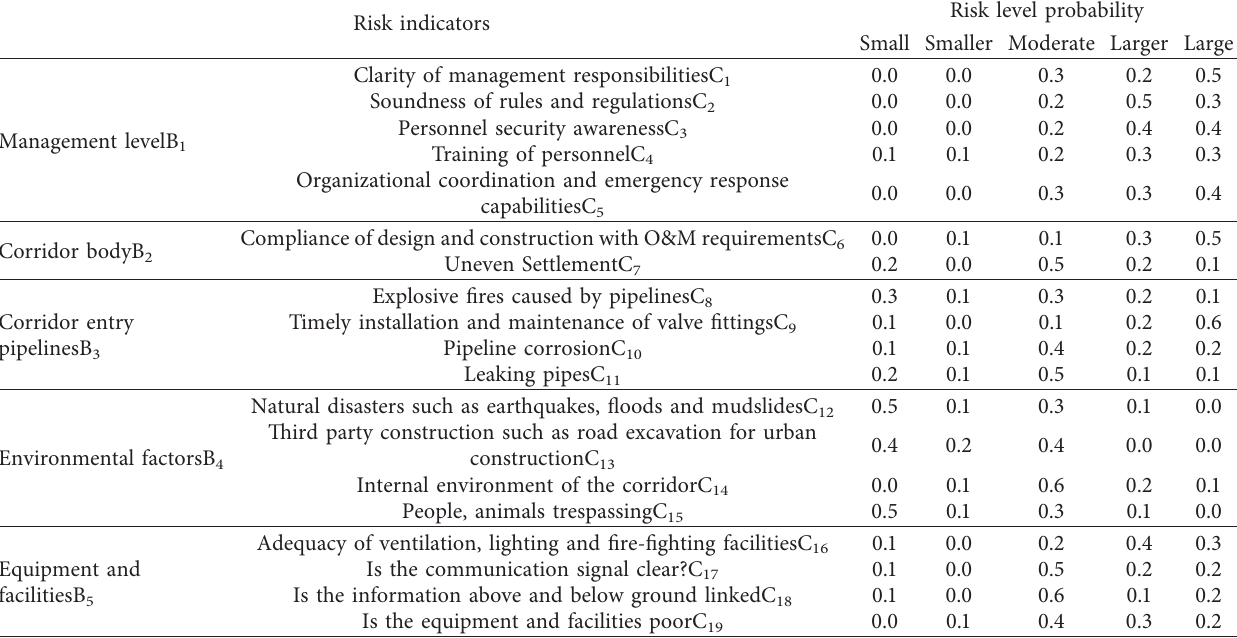
Table 5: Risk rating probability table for the operation and maintenance of the northern ring tunnel integrated corridor in the Tongzhou canal core